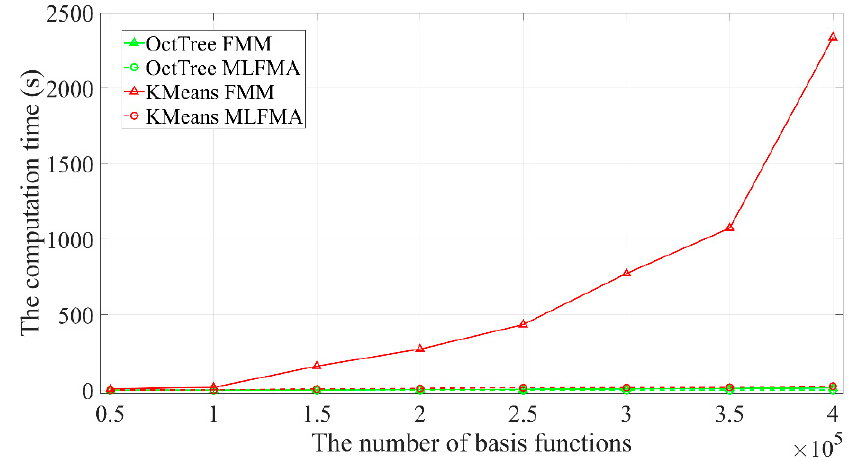
Figure 8. Comparisons the transfer function pre-computation time between the existing method and the proposed method as a function of the number of basis functions.